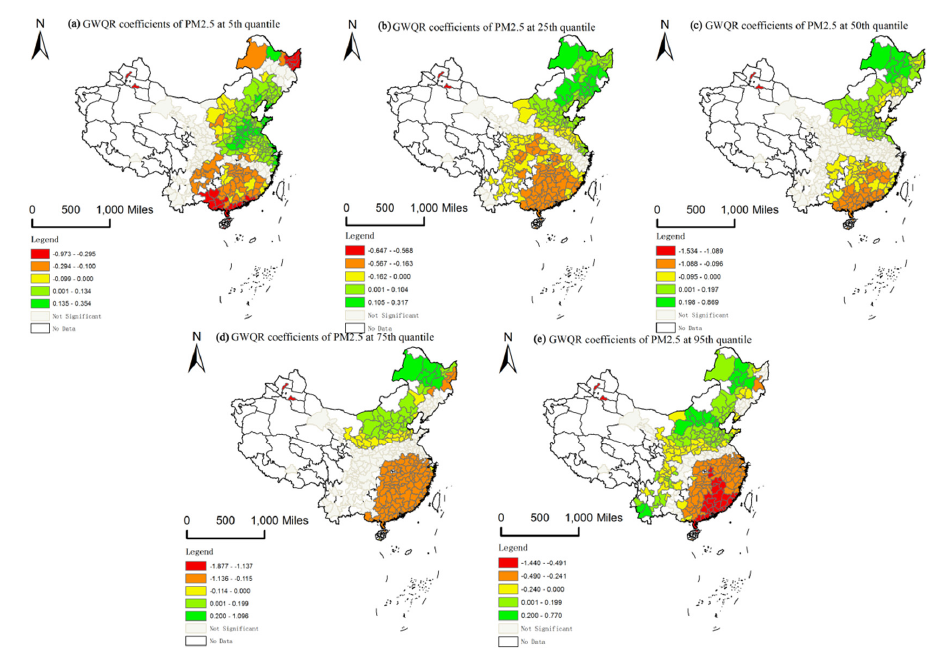
Figure A1. Spatial visualization of significant PM2.5 coefficients of GWQR for 2005. ( a )–( e ) represent the spatial distribution of significant PM2.5 coefficients for the 5th, 25th, 50th, 75th, and 95th quantiles respectively.